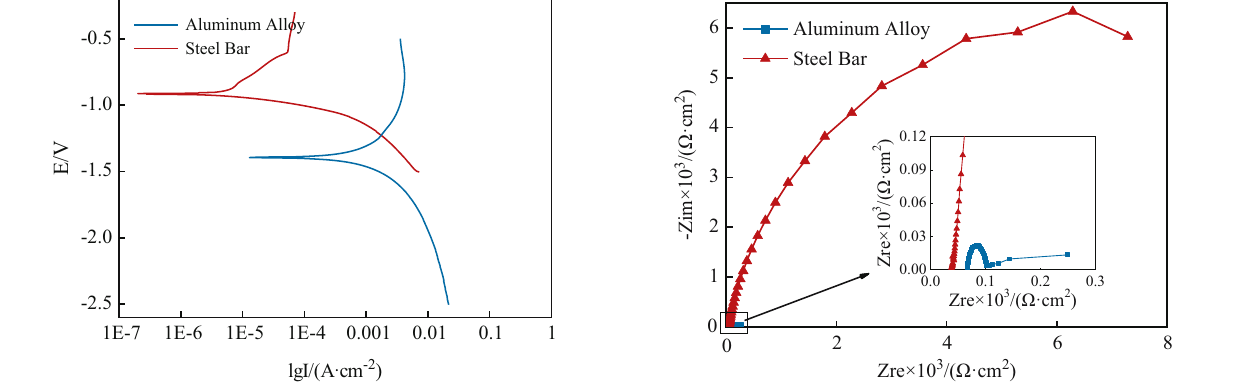
Figure 13: AC impedance spectroscopy of aluminium alloy and steel bar in the saturated Ca ( OH ) 2